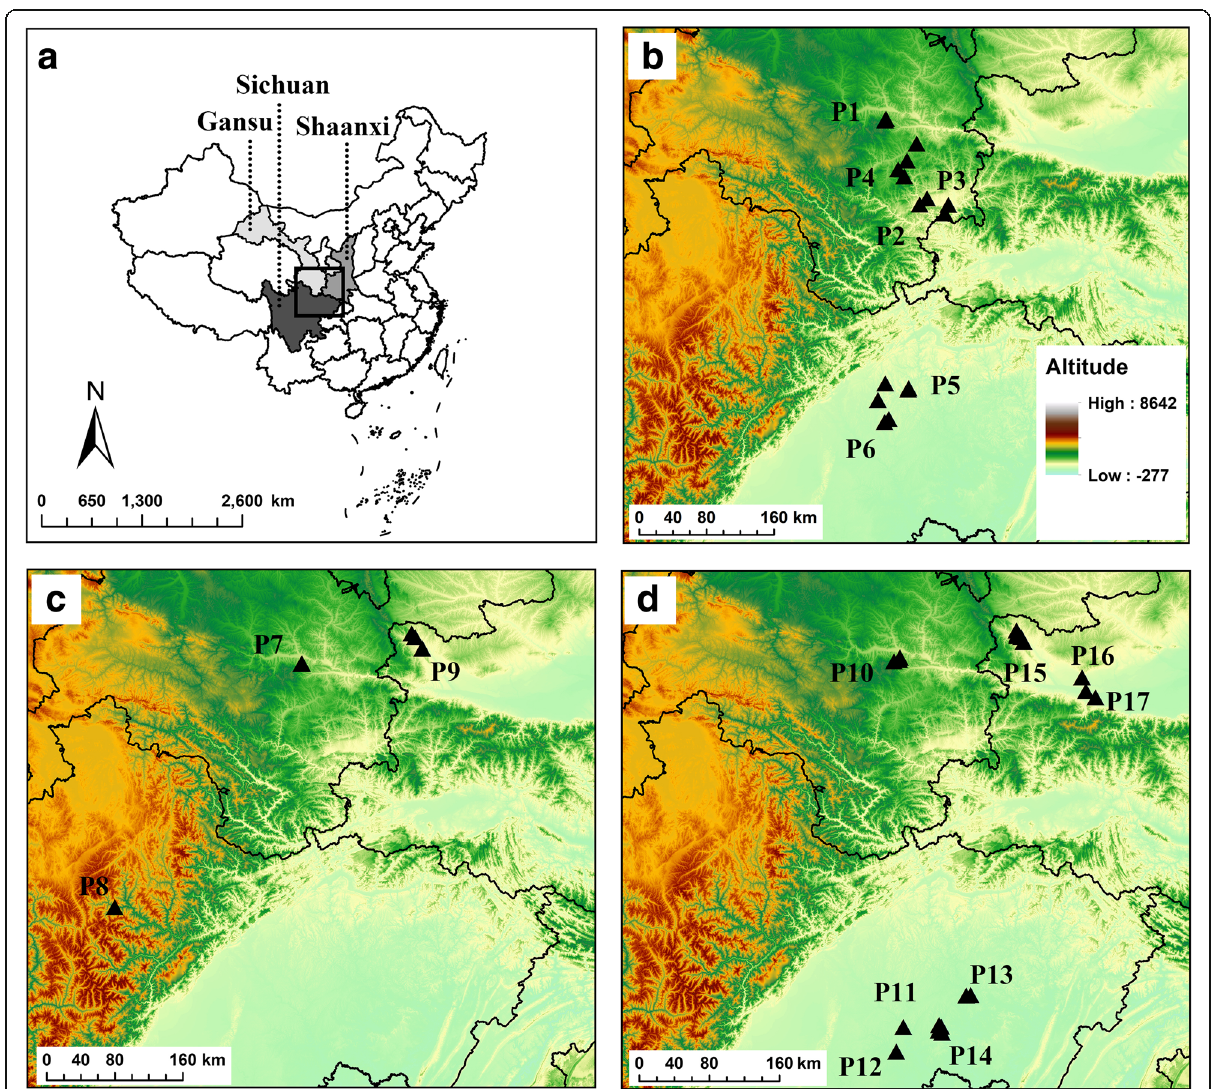
Fig. 6 Geographical locations where isolates of Puccinia striiformis f. sp. tritici were collected in this study. a The overall view of the study area, which was marked with a square frame, on the map of China; as well as the enlarged views of the study area showing the locations of samples collected in: b the spring of 2013, c the autumn of 2013, and d the spring of 2014. Due to the limited space, population code (P1-P17) was abbreviated from GS-P1-S13, GS-P2-S13, GS-P3-S13, GS-P4-S13, SC-P5-S13, SC-P6-S13, GS-P7-A13, SC-P8-A13, SX-P9-A13, GS-P10-S14, SC-P11-S14, SC-P12-S14, SC-P13-S14, SC-P14-S14, SX-P15-S14, SX-P16-S14, and SX-P17-S14,